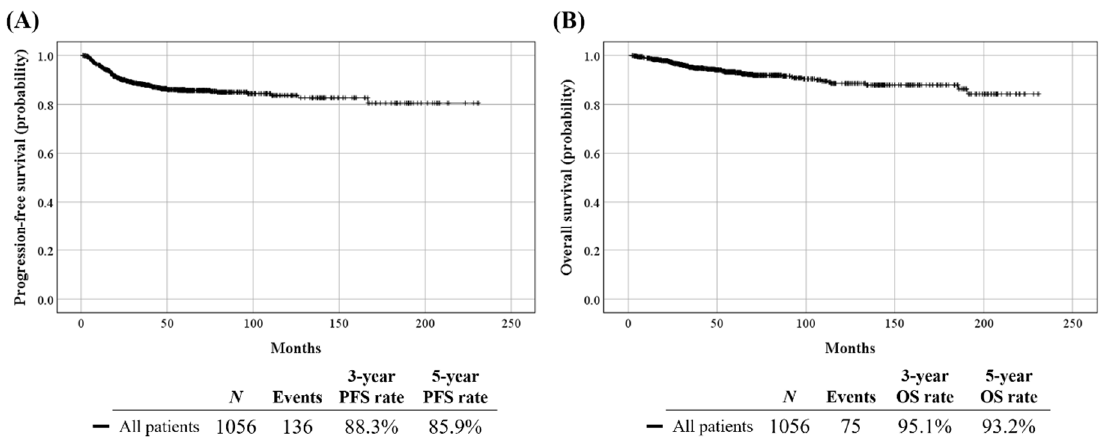
Figure 2. Survival outcomes of the study population: ( A ) PFS; ( B ) OS.